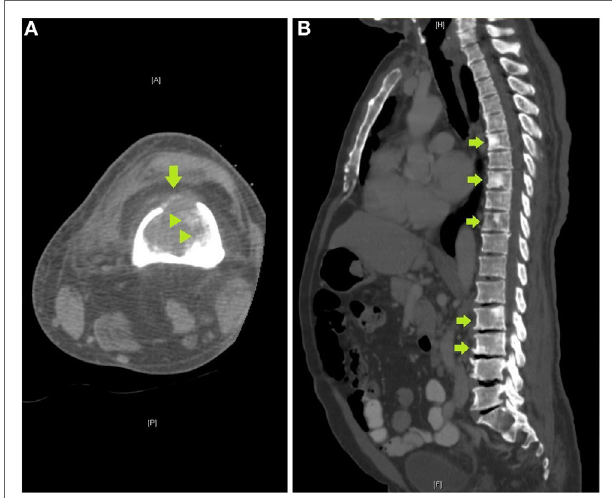
FIgURe 3 | (a) Axial computed tomography (CT) image of the femur obtained to localize the lesion for CT­guided biopsy demonstrates a destructive lytic lesion with cortical breakthrough anteriorly (arrow) and areas of bone sclerosis (arrowheads), (B) sagittal image of a CT of the chest, abdomen, and pelvis demonstrates multiple sclerotic lesions in the spine, including within T6, T8, T10, L2, and L3 vertebrae (arrows).